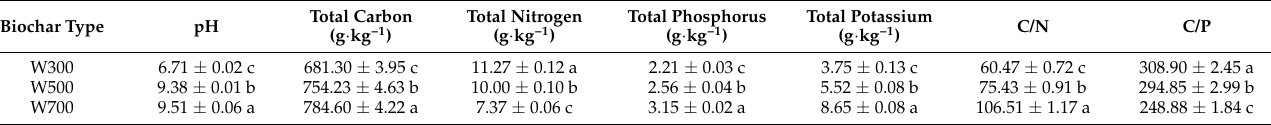
Table 2. Basic chemical properties of wingnut-based biochar pyrolyzed at different